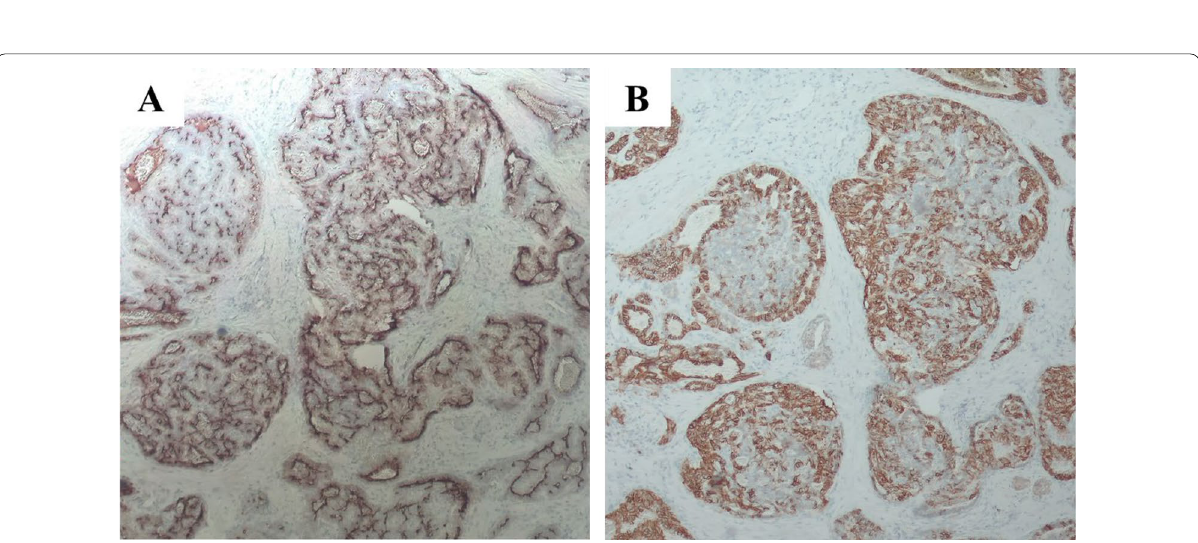
Fig. 6 Findings of immunohistochemical staining. A Epithelial membrane antigen (EMA) was strongly stained in the membrane of the cancer duct, showing a characteristic membranous pattern. B Neural cell adhesion molecule 1 (NCAM1) was positive in the cytoplasm of the tumor cells ( A B ×